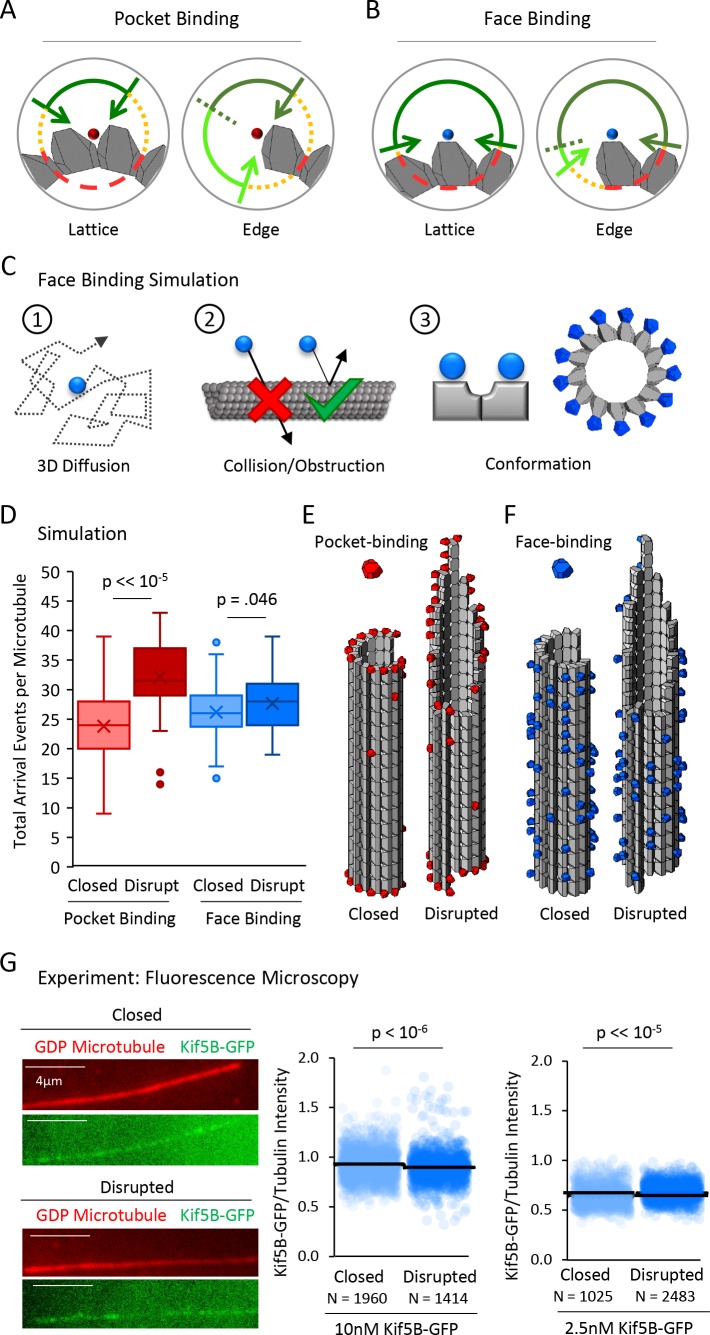
A tubulin face binding protein does not demonstrate microtubule structure recognition in experiment and simulation.(A) Hypothesis schematic showing large increase in direct access to a pocket binding site (dark green + light green) upon change from lattice conformation (left) to an edge conformation (right) for a pocket-binding protein. (B) Face binding hypothesis model predicts only a small change in direct access to a face binding site upon change from lattice conformation (left) to an edge conformation (right). (C) Simulation rules and parameters for face binding are identical to a pocket binding simulation with respect to (1) 3D diffusion, and (2) obstruction of the binding molecule by tubulin molecules. (3) The only change in the simulation was in the location of the binding site (left), with the arrangement of simulated face-binding protein on a microtubule at right. (D) Total arrival events per microtubule for a simulated pocket binding protein (EB1, red) and face binding protein (blue), showing molecular arrival events on closed (light red/light blue) and ‘disrupted-structure’ (dark red/dark blue) microtubule conformations. Results of 50 simulations of 4,000 EB1 molecules each for each microtubule condition. Each data point in the box and whisker plots represents the total number of EB1 arrival events per microtubule for 4000 different simulated EB1 molecules. (E) Representative visualizations of arrival event location distribution of pocket binding protein such as EB1 (red) on closed and disrupted-structure microtubules. (F) Representative visualizations of arrival event location distribution of face binding protein (blue) on closed and disrupted-structure microtubules, illustrating the loss of preference for edge-located binding sites. (G) Left: Representative images of Kif5B-GFP (green), which is a tubulin face binding protein, on GDP microtubules (red) (scale bar 4 µm). Right: Cloud plots of Kif5B-GFP/Tubulin intensity ratio for individual microtubules. Each semi-transparent circle is the data point from a single microtubule. Solid lines are the average Kif5B-GFP/Tubulin intensity ratio for each population.